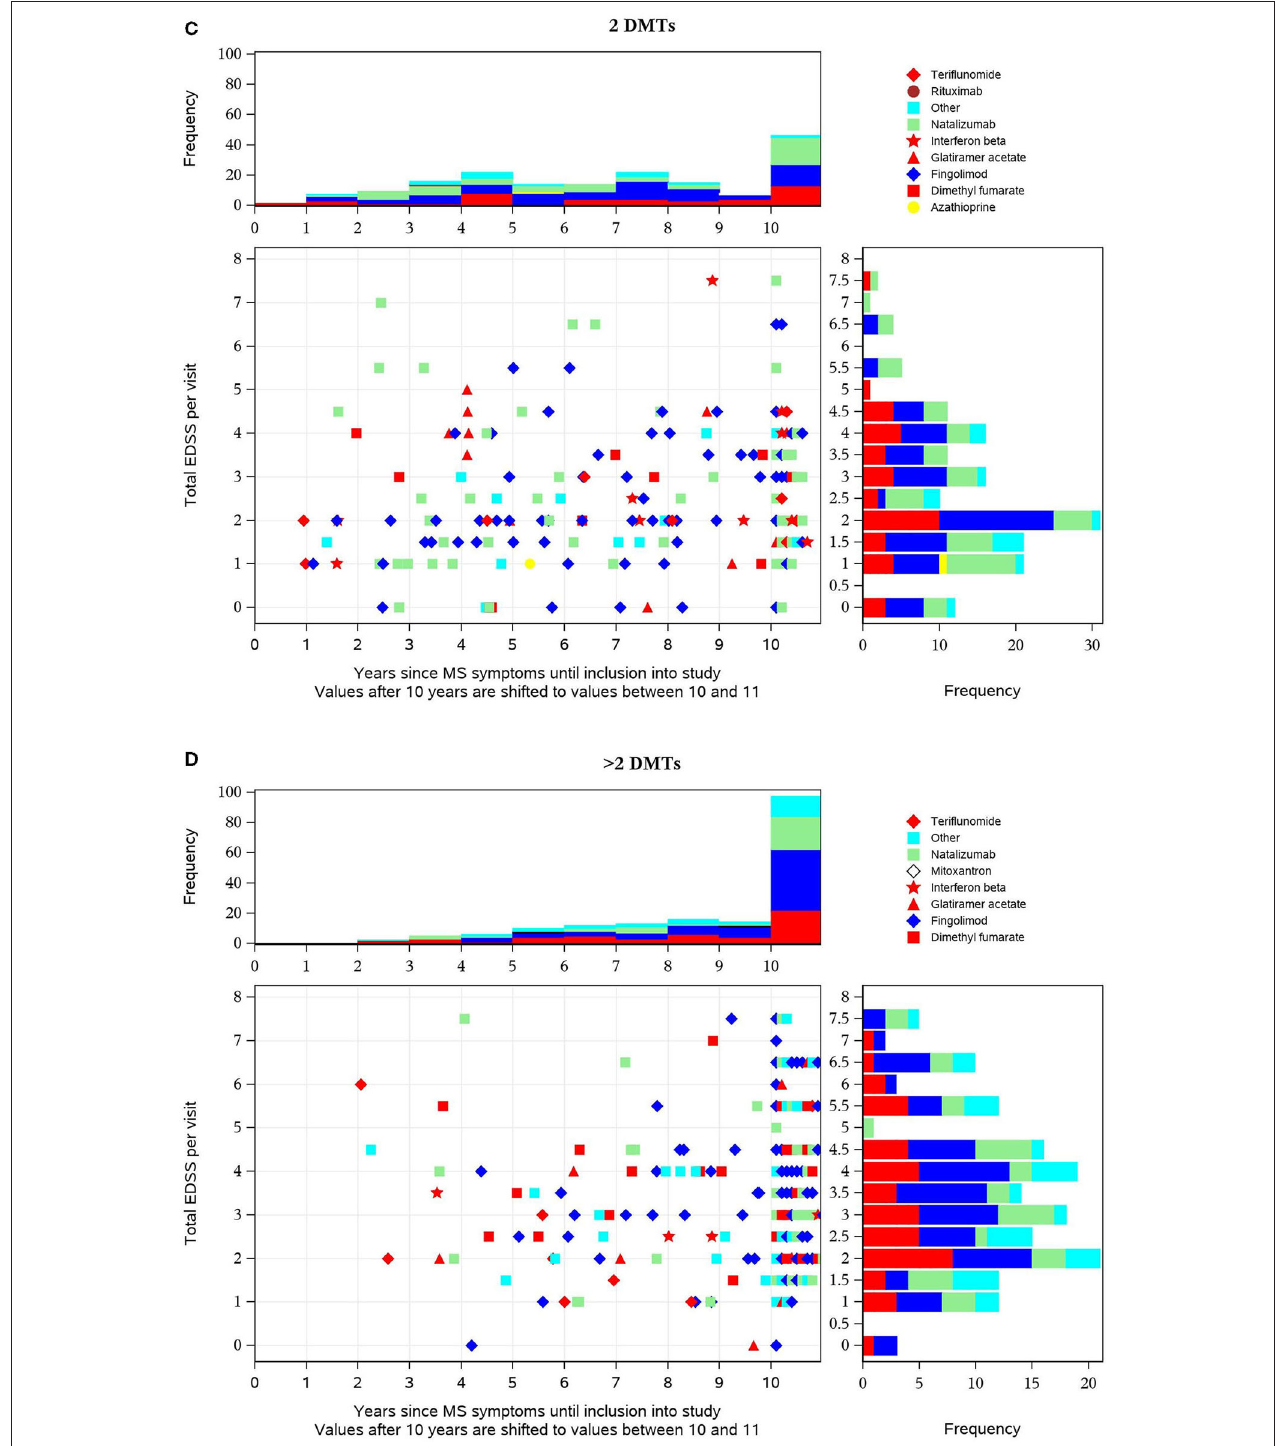
FIGURE 2 | (A–D) Distribution of Expanded Disability Status Scale (EDSS) values (y-axis) vs. disease duration before inclusion into the study (x-axis) by disease-modifying treatment (DMT) pretreatment. Each dot in the diagram represents one patient’s value in relation to both parameters at baseline. For pretreated patients, the most recent DMT is distinguished by different symbols as indicated in the legend and the basic therapies glatiramer acetate, dimethyl fumarate (DMF), interferon-beta, and teriflunomide are colored red so that they can be easily distinguished from escalation therapies. The horizontal bars on the right show the distribution (histogram with frequencies in percent) of EDSS values, the vertical bars above the scatterplot the distribution of time intervals across all patients (percentage).